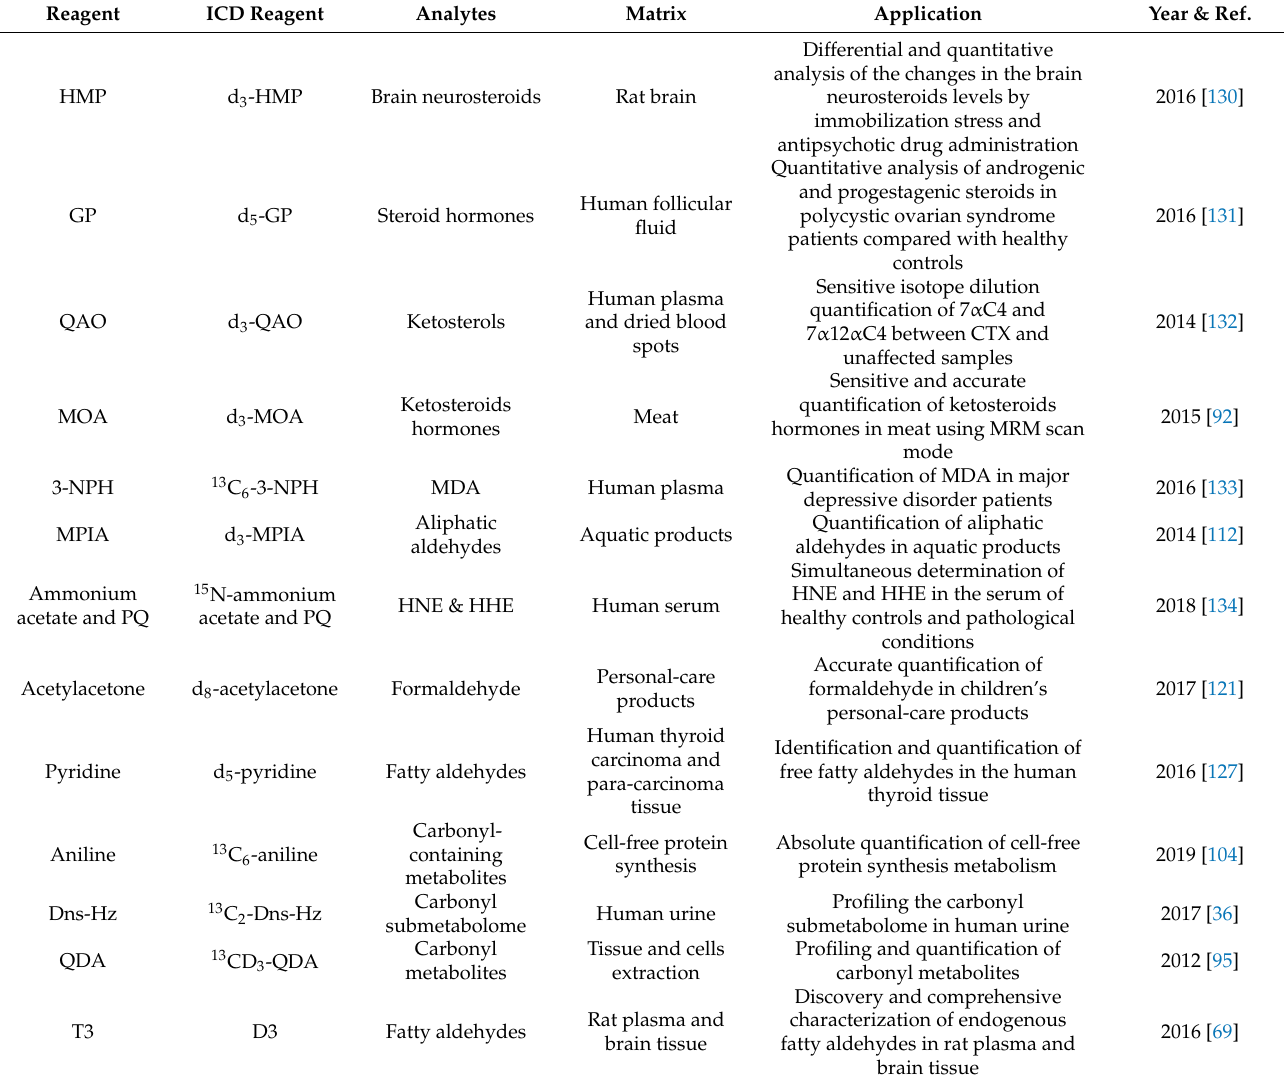
Table 1. Summary of ICD reagents for carbonyl-containing metabolites and their